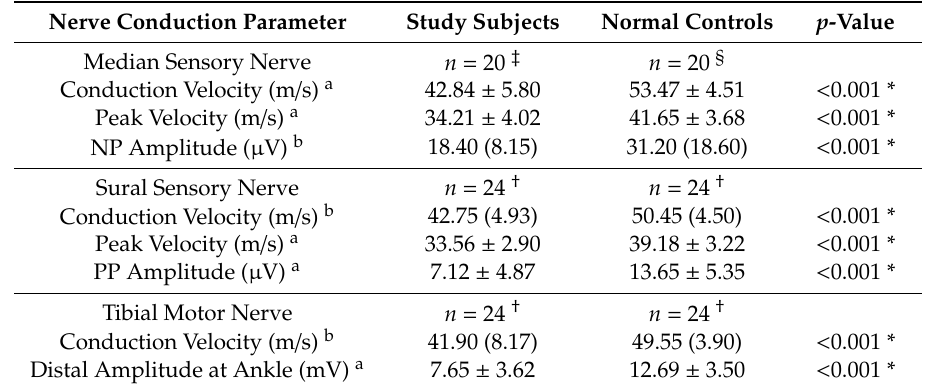
Table 1. Age-matched comparison of nerve conduction parameters in median, sural and tibial nerves between study subjects and normal controls. Nerve Conduction Parameter Study Subjects Normal Controls p